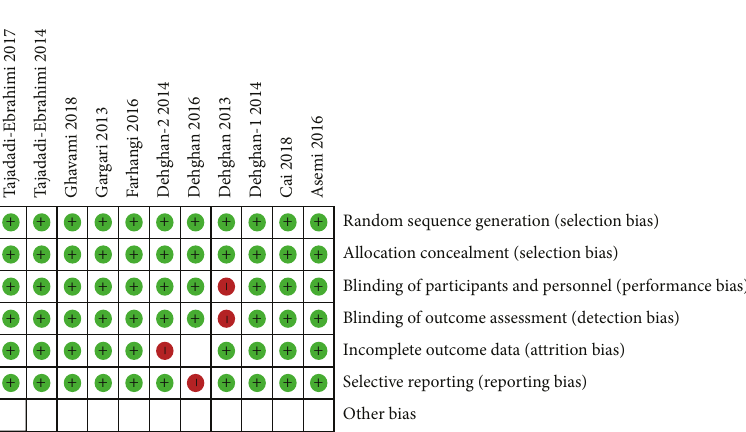
Figure 1: Flow diagram showing study selection.